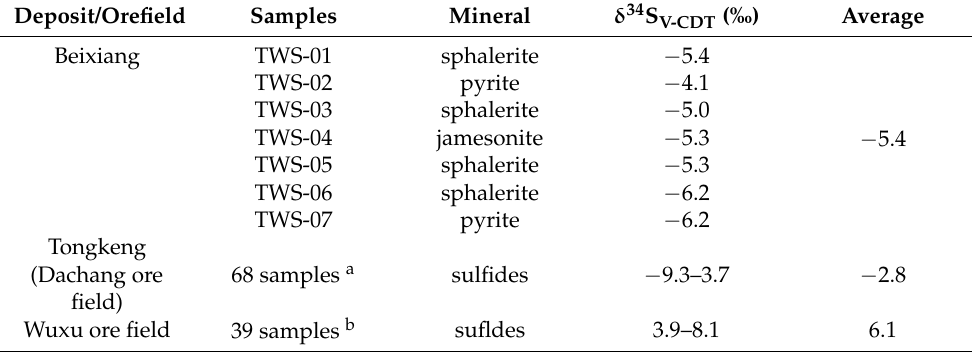
Table 3. Sulfur isotopic compositions of the Beixiang deposit.